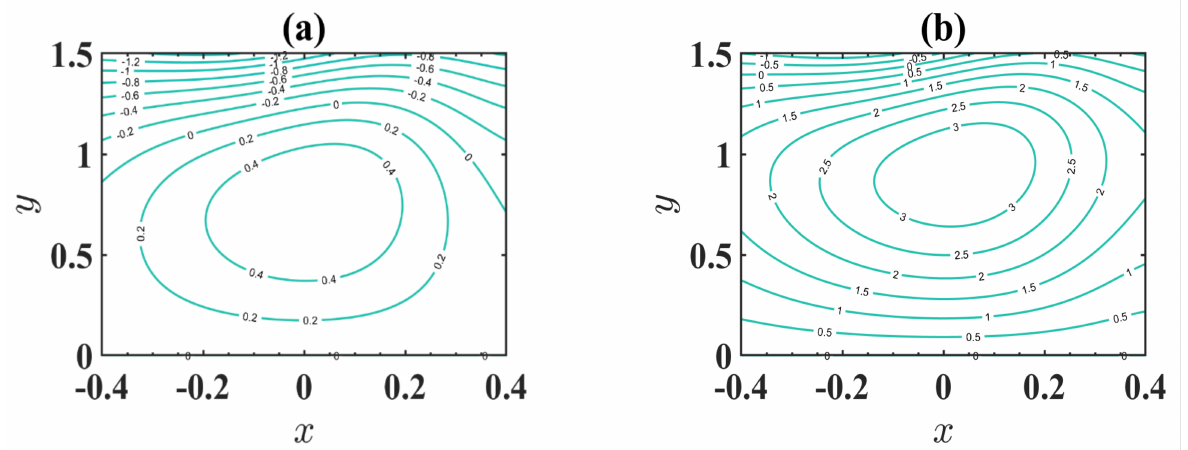
Figure 9. Streamline for varying ( a ) λ 1 = 0 and ( b ) λ 1 =